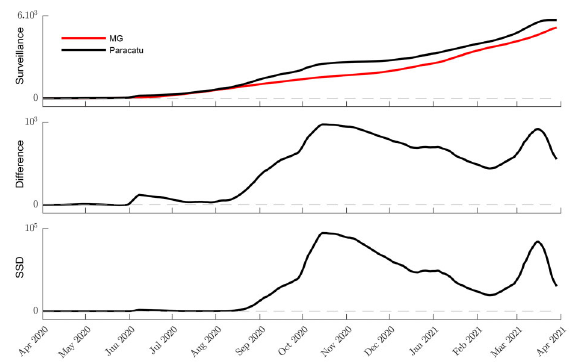
Figure 3. Details of signed squared difference (SSD) time series construction. The SSD was developed to show the evolution of municipality data in relation to the state, considered as a reference curve. The fi gure shows both the difference and the SSD time series. The difference signal can be considered a detrended time series (in relation to state time series). The SSD time series was used to spotlight when the surveillance data of one municipality deviated from the reference.